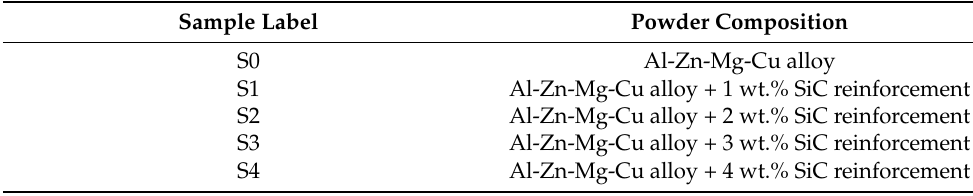
Table 1. Sample labels of as-printed Al-Zn-Mg-Cu alloy and SiC/Al-Zn-Mg-Cu